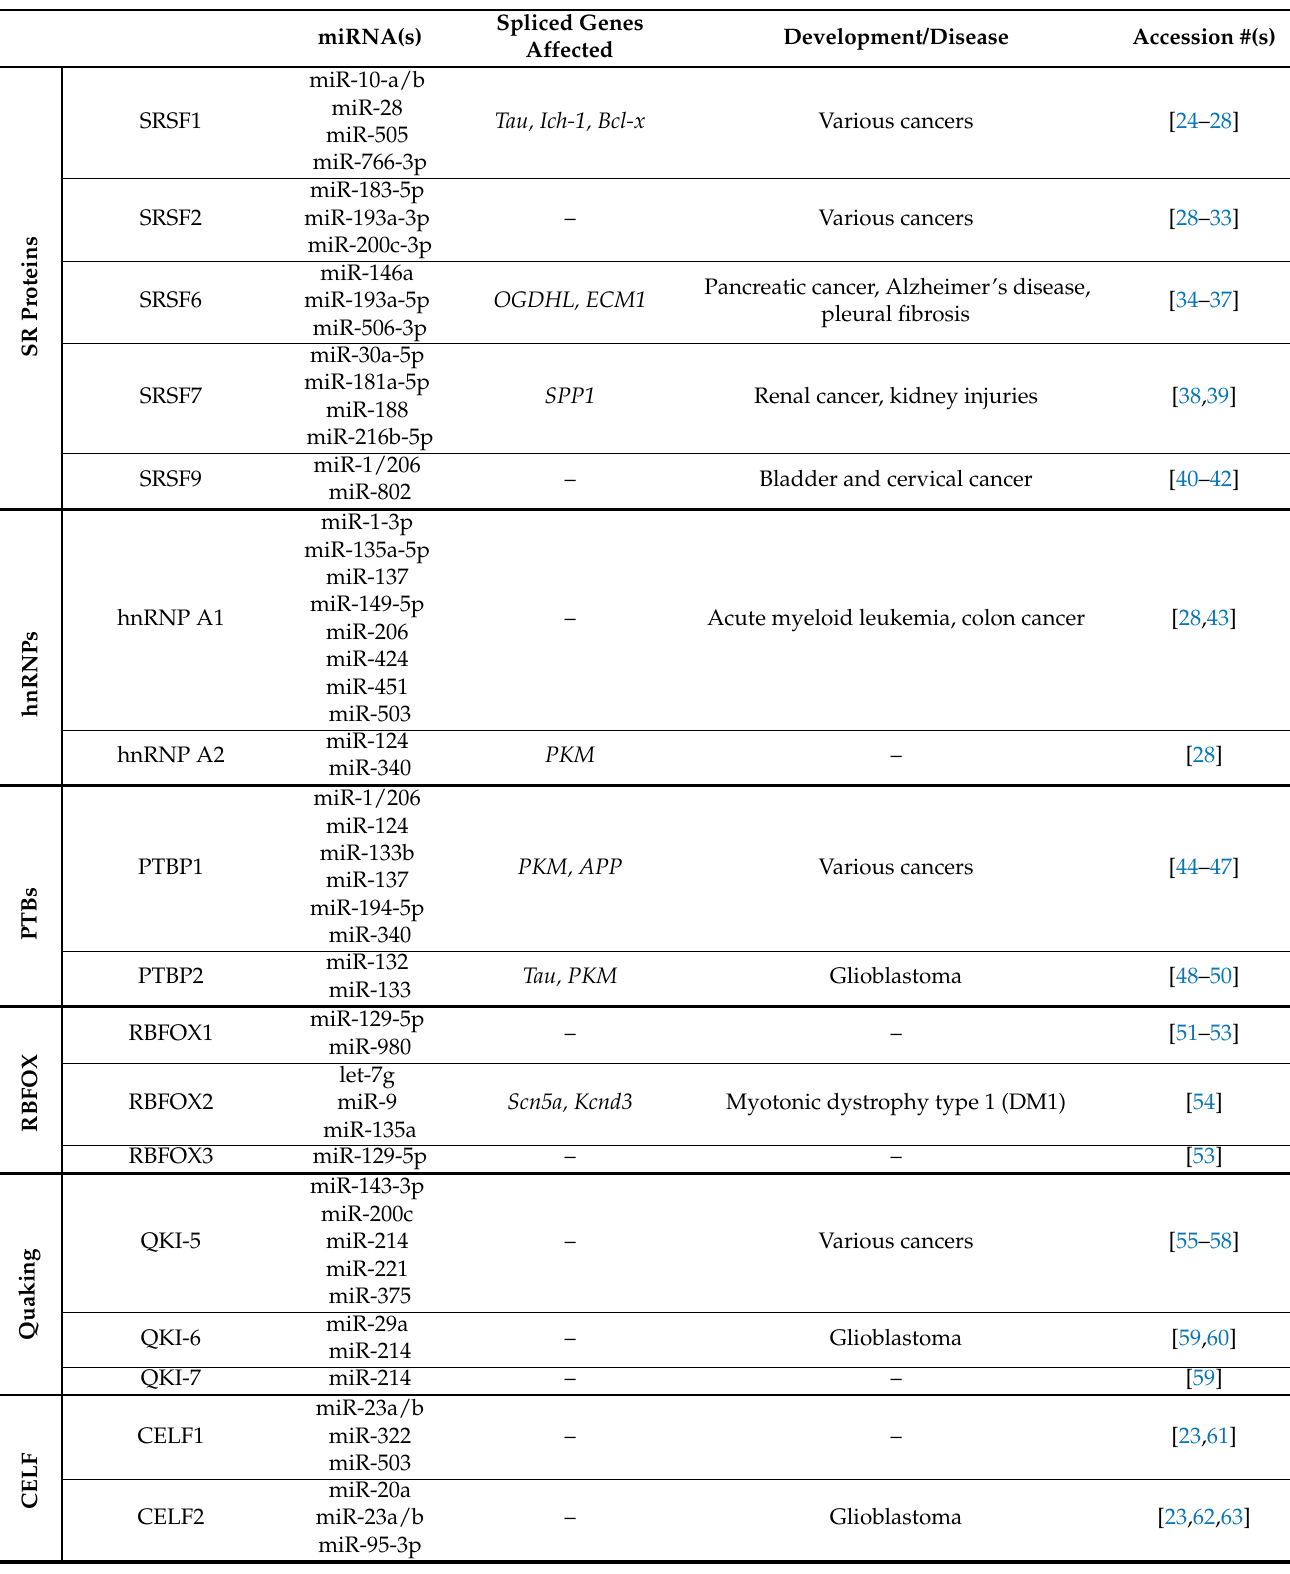
Table 1. Summary of the RNA splicing factors discussed in this